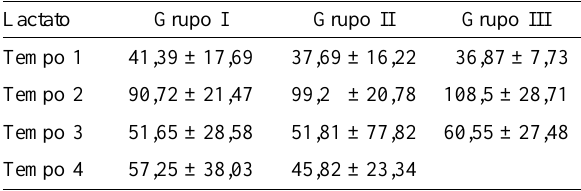
três horas de reperfusão.